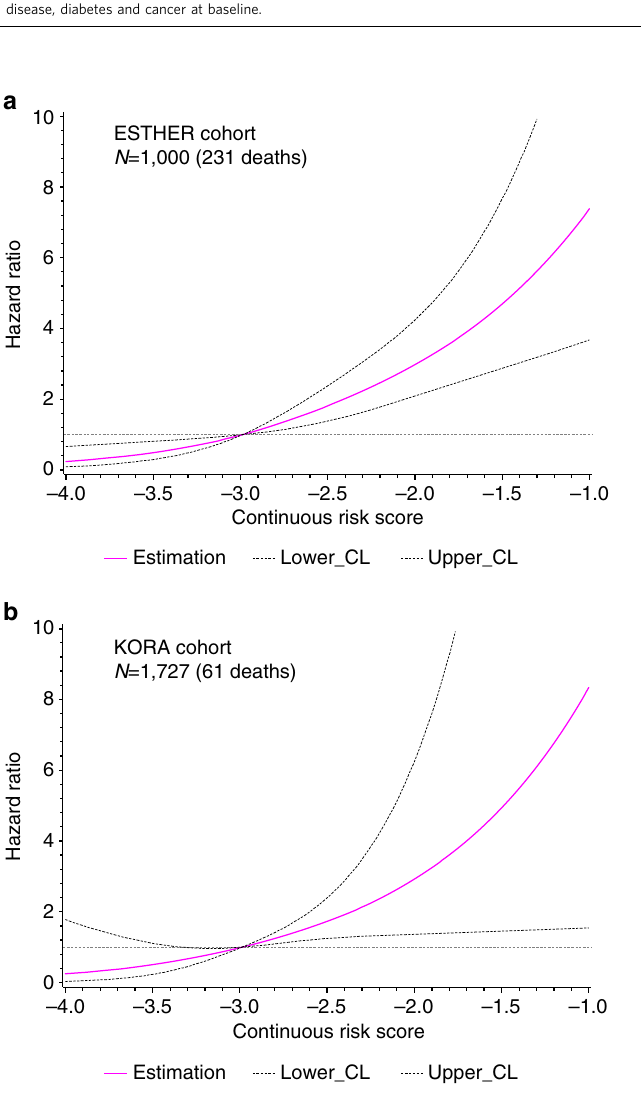
Figure 2 | Dose–response relationships between continuous risk score and all-cause mortality. ( a ) Dose–response curve in the ESTHER study ( N ¼ 1,000 (231 deaths)); ( b ) dose–response curve in the KORA study ( N ¼ 1,727 (61